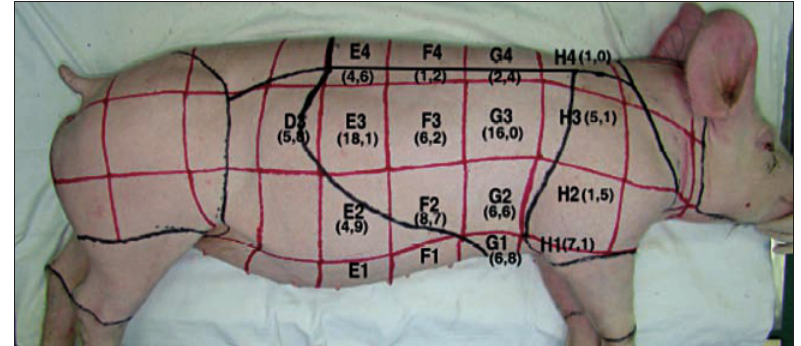
Fig. 6. Perforator detection averages in the thoracic